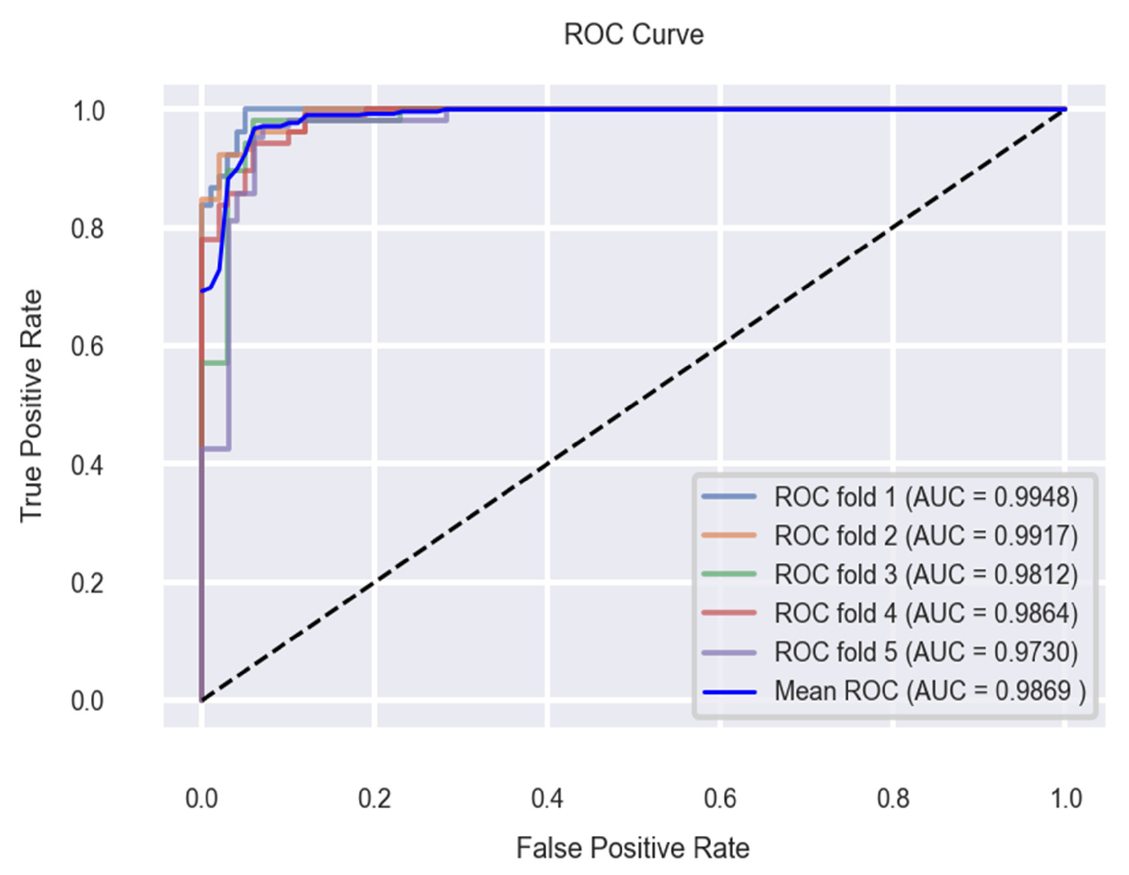
Figure 26. Stratified (K = 5)-Fold Cross-validation Results for NuSVC (ROC-AUC).